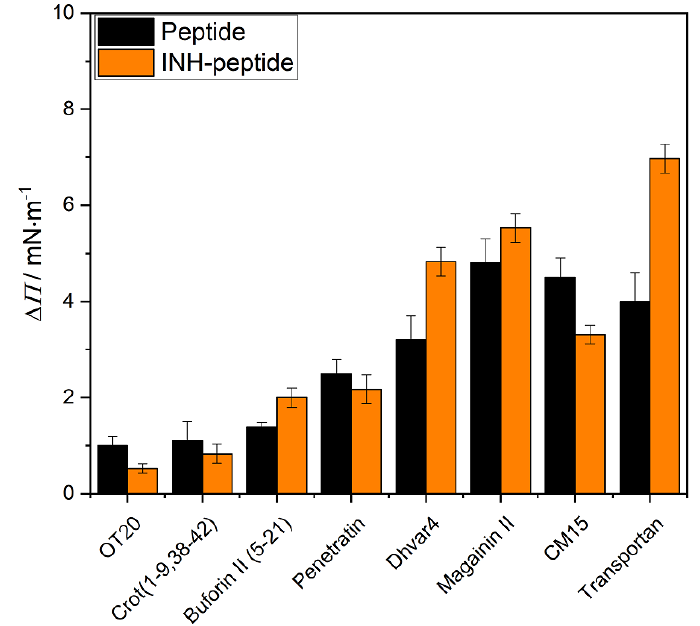
Figure 1. The degree of penetration ( ∆Π ) of the original peptides (black) and their INH conjugated derivatives (orange) into DPPC lipid monolayer after 1 h interaction. (The peptides are presented according to their increasing R t values.)